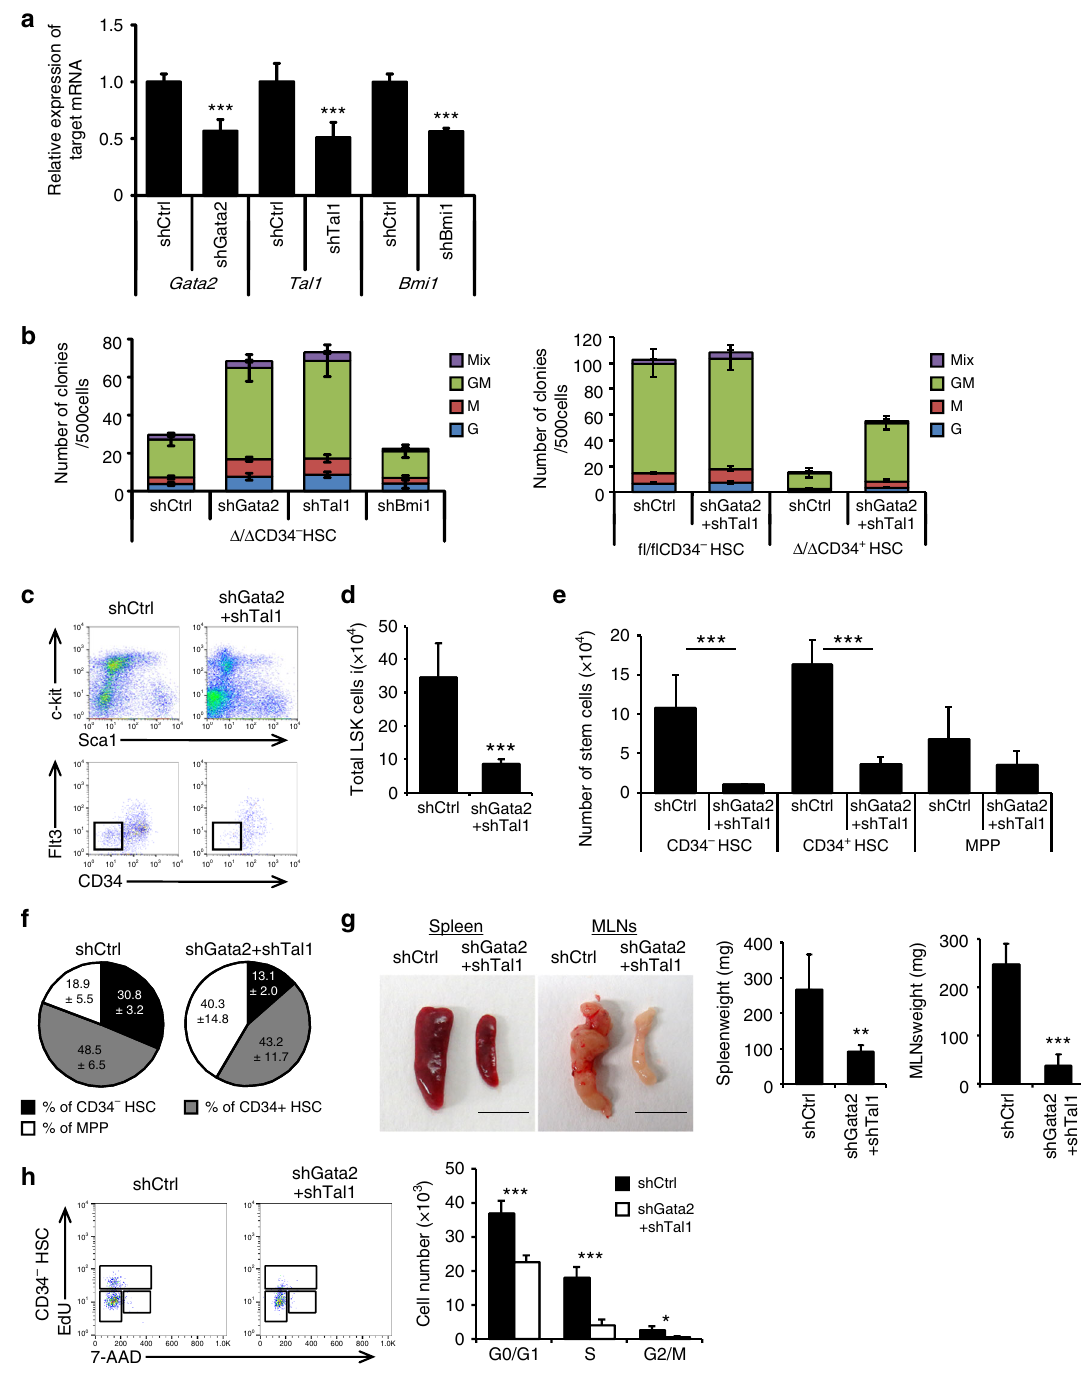
expression vector 33 or empty vector (pcDNA3) were performed using FuGENE HD transfection reagent (Promega) according to manufacturer ’ s instructions. Proliferation of HL60 and THP-1 cells was evaluated using Cell Counting Kit-8 (Dojindo). All of the cells were authenticated by examination of morphology and growth characteristics, and were con fi rmed to be mycoplasma-free. Immunohistochemical analysis . Tissue fi xation and staining of sections or tissues with antibodies was performed by the following method. Freshly-excised femoral or tibial bone from WT mice was embedded in super cryoembedding medium (Leica Microsystems) and frozen in liquid nitrogen. Next, 10- μ m cryosections were gener- ated via the Kawamoto fi lm method 54 . An anti-c-Kit (AF1356, R&D Systems, dilution 1/100), anti-Sca1 (553333, BD Biosciences, dilution 1/100), anti-CD71 (113802, Biolegend, dilution 1/100) and, anti-Regnase-1 antibodies (dilution 1/100) 16 were used for staining 55 . Cell nuclei were visualized with TO-PRO-3 and sections were